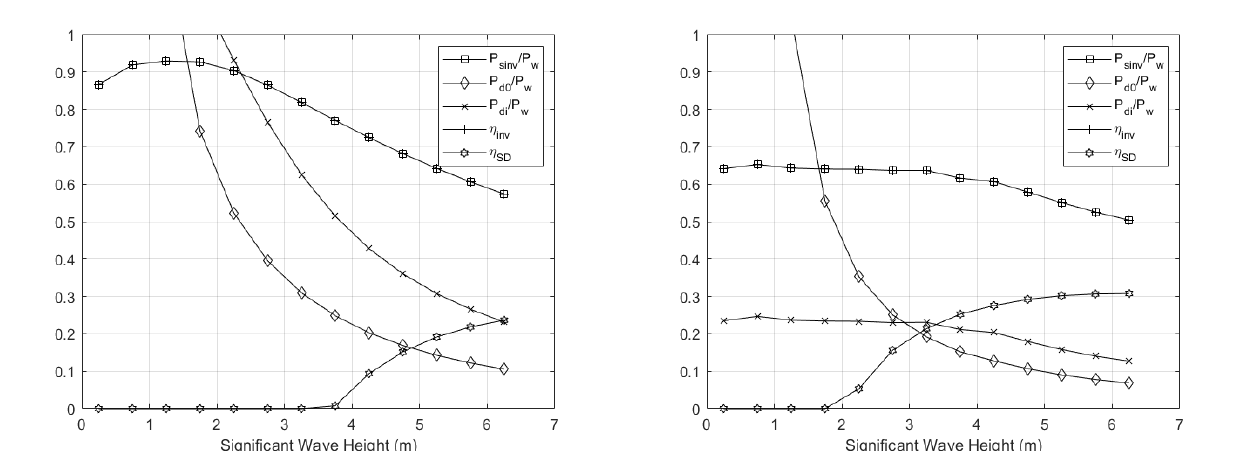
Fig. 12: Cancelled wave power, drag power losses normalized with incoming wave power and inviscid and total efficiency of power conversion for the CycWEC from irregular wave simulations at a constant significant wave period, Ts = 9s. Left, controller 1. Right, controller 2.